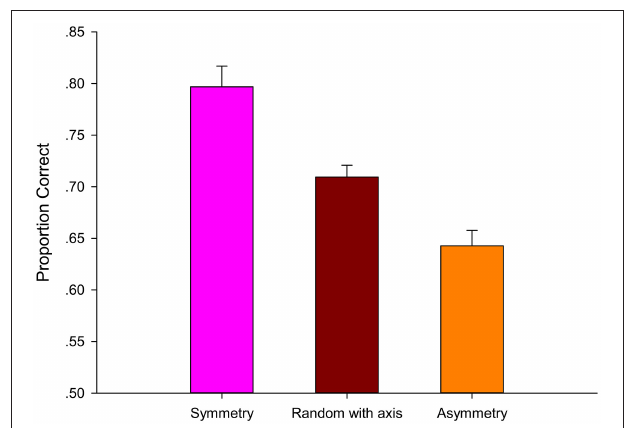
FIGURE 5 | Average tracking performance as a function of target position and standard error in Experiment 2.